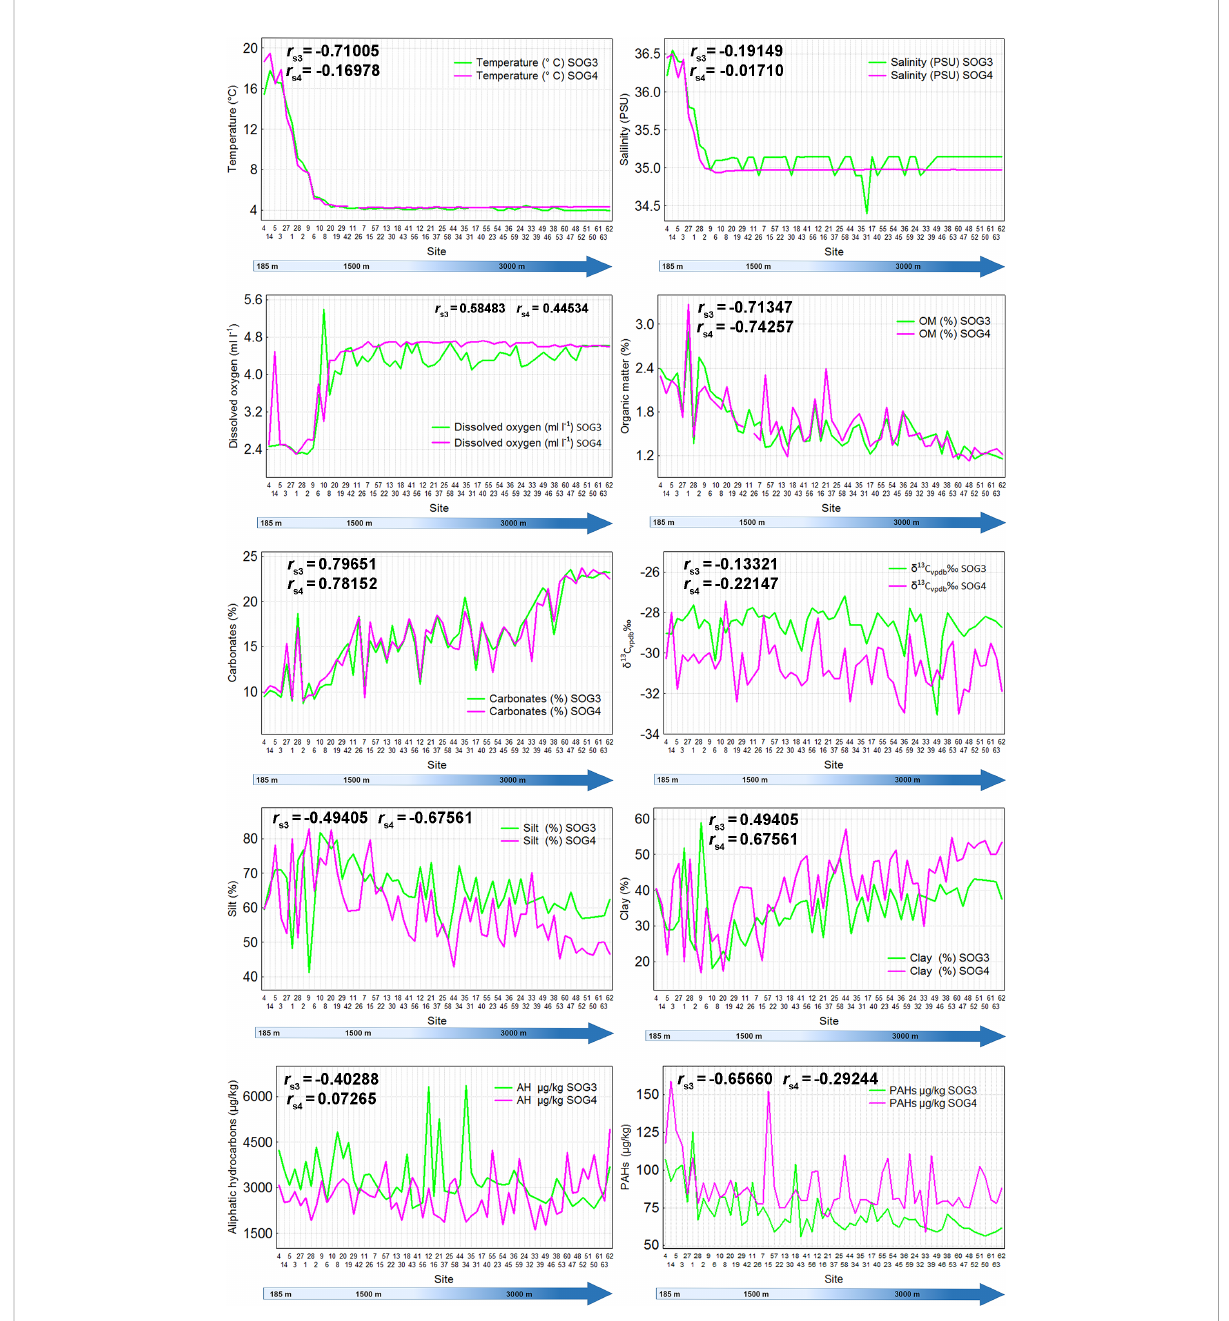
FIGURE 2 Depth related pattern of environmental factors (sites are ordered from low to highest depth, left to right). SOG3 = SOGOM 3, SOG4 = SOGOM 4, AH = Aliphatic hydrocarbons, PAHs = Polycyclic Aromatic Hydrocarbons, r s3 = Spearman ’ s correlation coef fi cient during SOGOM 3, r s4 = Spearman ’ s correlation coef fi cient during SOGOM